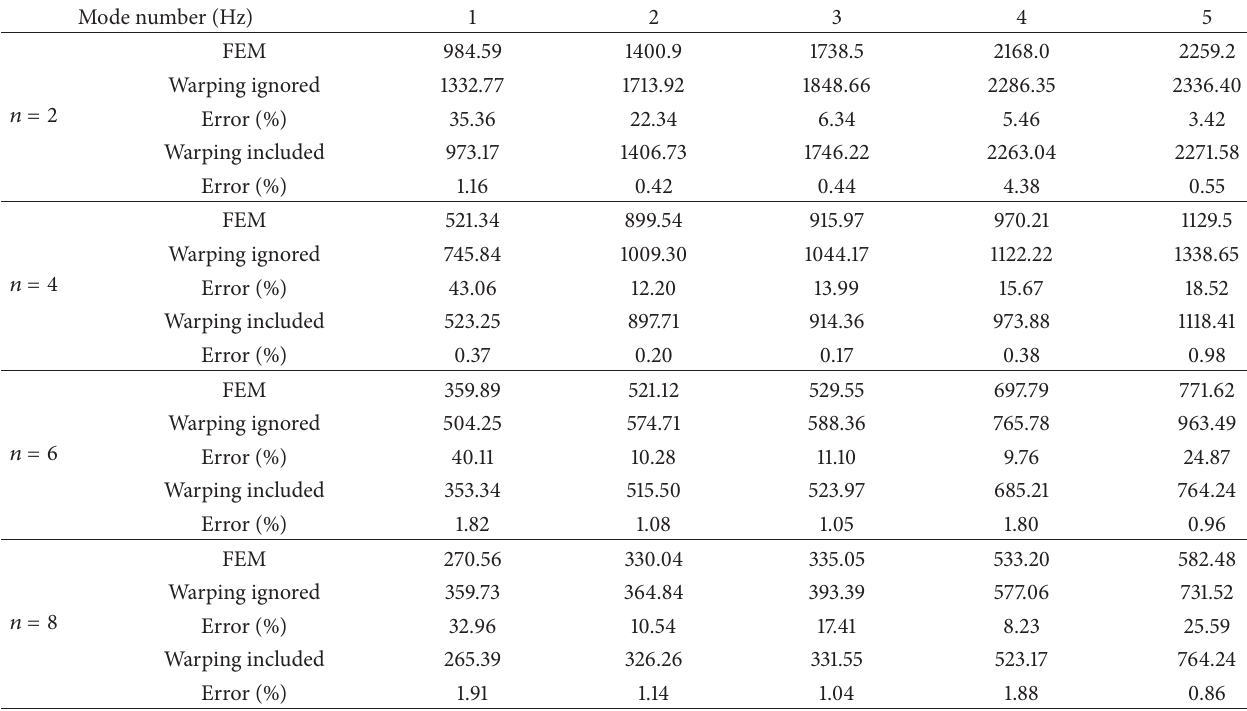
Table 5: Change law of the warping effect on natural frequencies with respect to the number of coils.